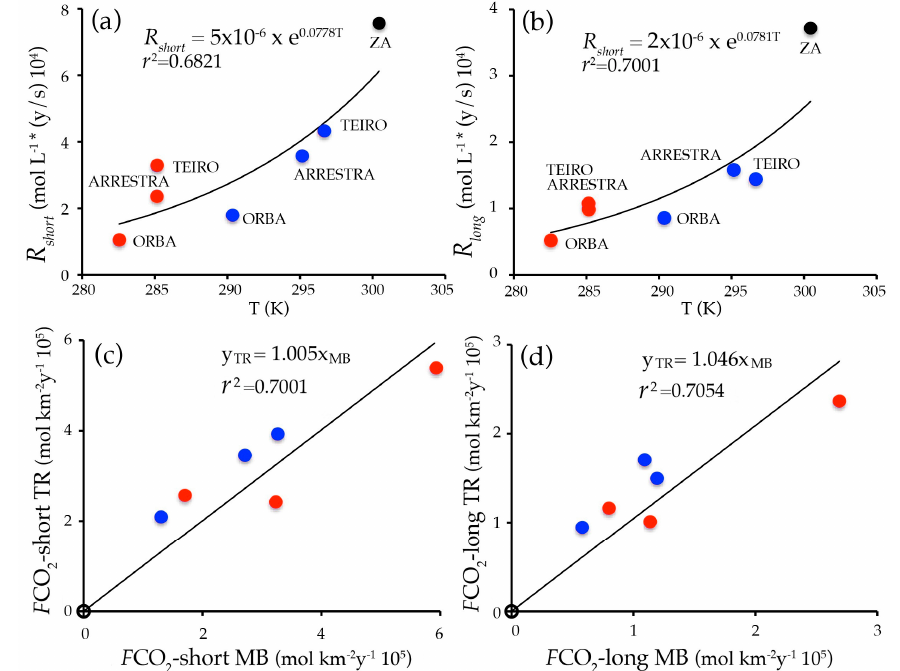
Figure 7. R short vs. T ( a ) and R long vs. T ( b ) diagrams. Red full circles indicate wet season, blue full circles indicate the dry season, ZA stands for Zambales and Angat ophiolites; ( c ) comparison of the F CO 2 -short values computed from the temperature regression (TR) of Equation (11) and the geochemical mass balance (MB); ( d ) comparison of the F CO 2 -long values computed from the temperature regression (TR) of Equation (12) and the geochemical mass balance